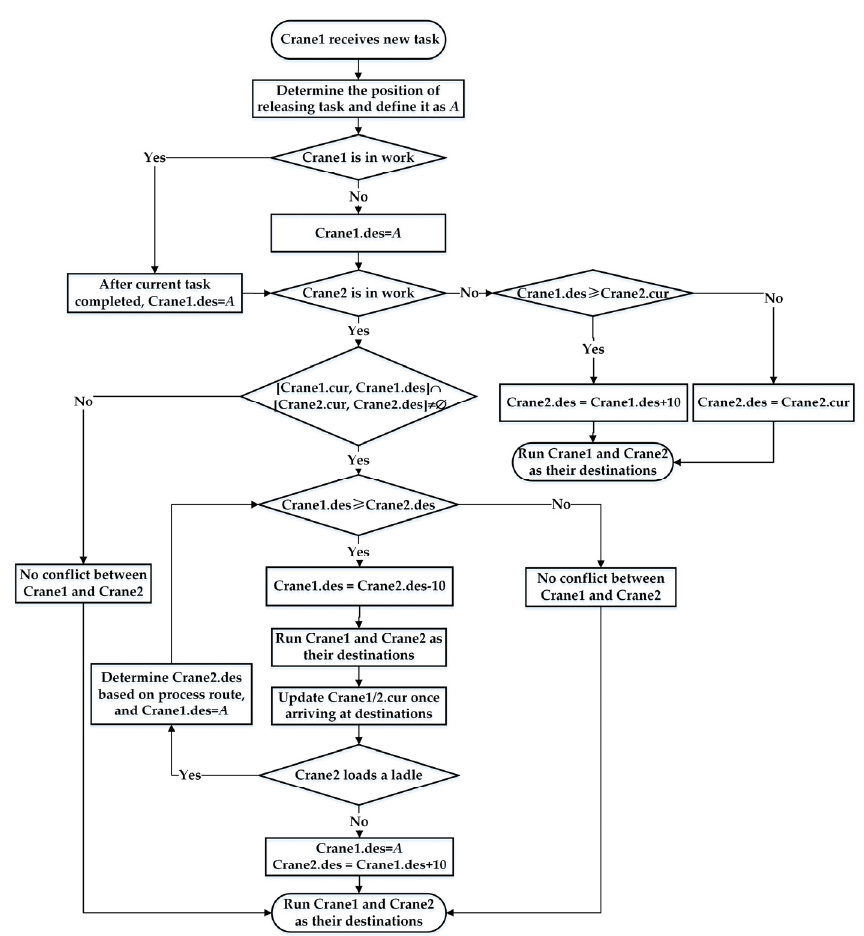
Figure 6. Conflict elimination strategy for adjacent cranes.